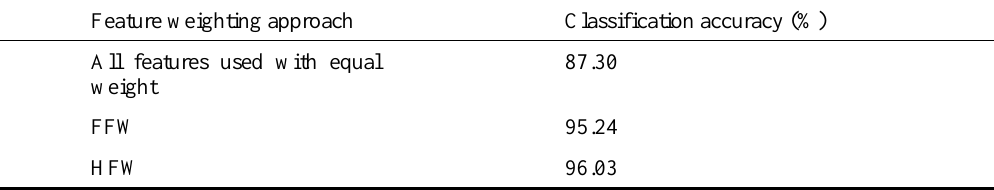
Table 1: Performance of different feature weighting approaches in terms of classification